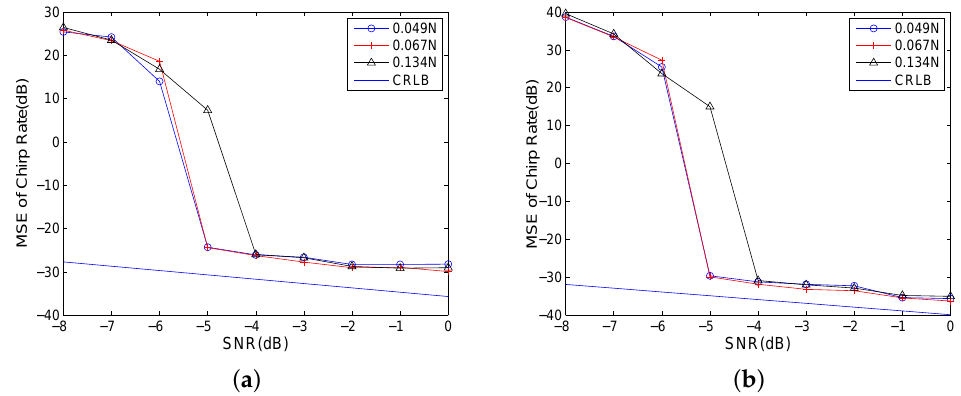
Figure 9. Sub-optimal scale factors analysis: ( a ) MSEs of QCR; and ( b ) MSEs of